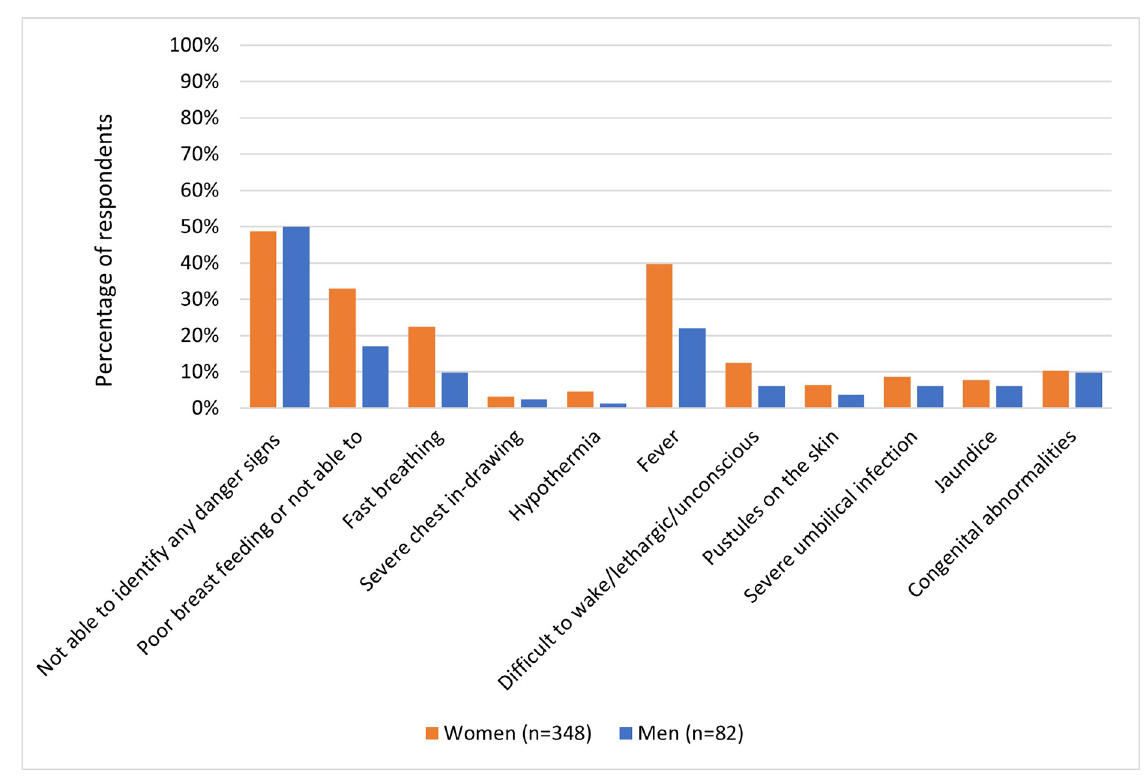
Fig 1. Identification of neonatal danger signs: Women and men �